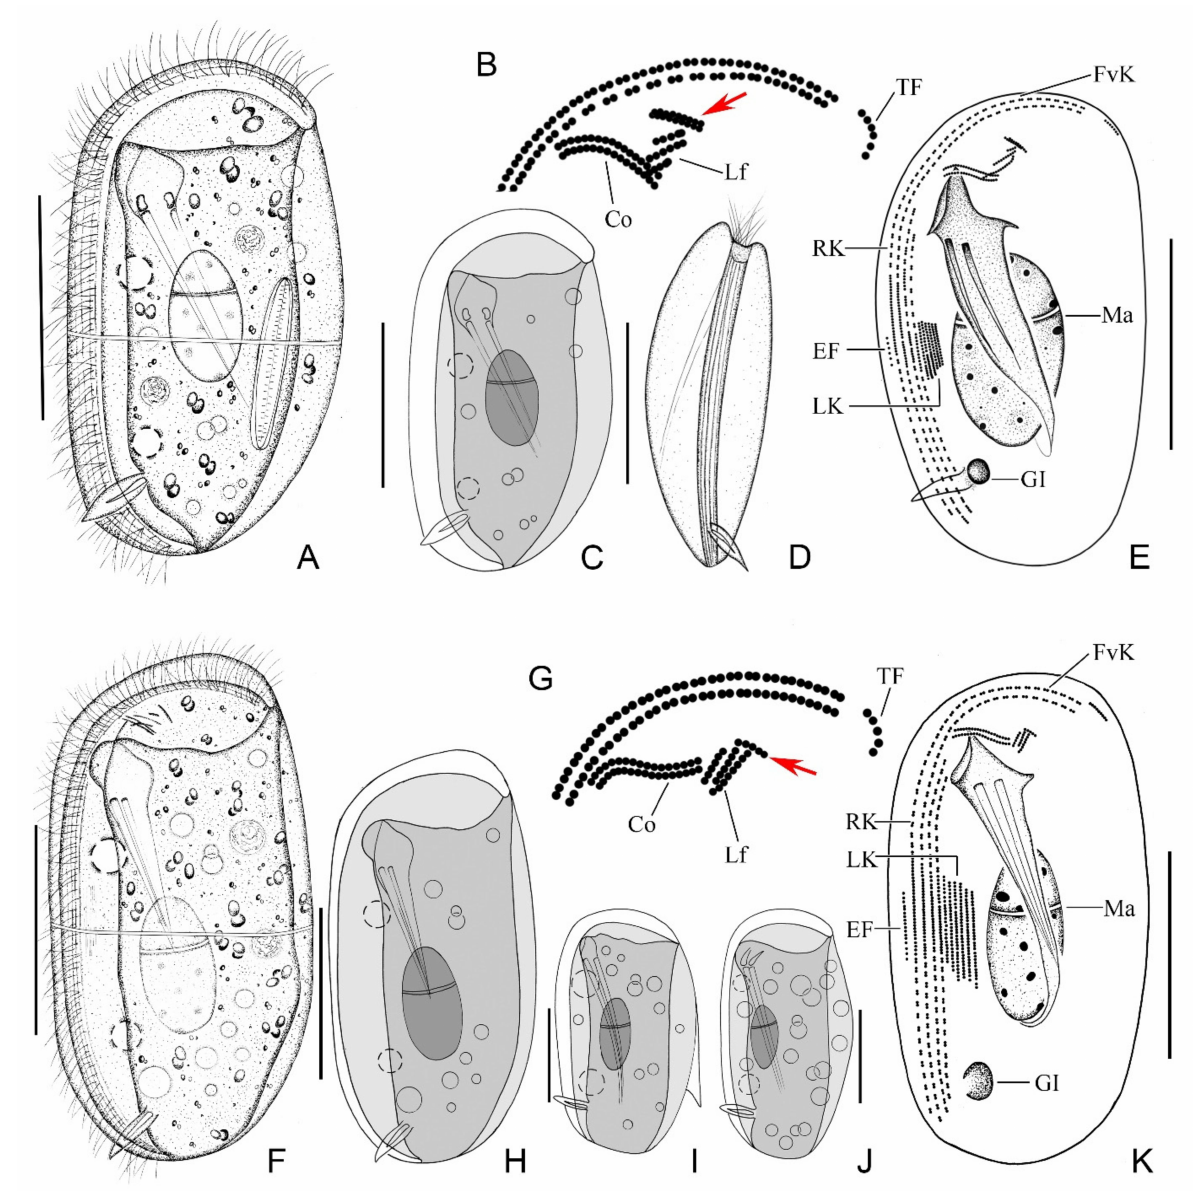
Figure 1. Dysteria paracrassipes n. sp. from life ( A , C , D ) and after protargol staining ( B , E ). Dysteria crassipes from life ( F , H – J ) and after protargol staining ( G , K ). ( A ) Left lateral view of a represen- tative individual. ( B ) Details of anterior region of cell showing the ciliary pattern; arrow shows double-rowed preoral kinety. ( C ) Showing the body shape. ( D ) Ventral view. ( E ) Left lateral view of the holotype specimen. ( F ) Left lateral view of a representative individual. ( G ) Details of anterior region of cell showing the ciliary pattern; arrow shows single-rowed preoral kinety. ( H ) Left lateral view of typical individual. ( I , J ) Representative individuals after Gong et al. [9]; note that the indi- vidual in ( I ) has a dorsal spine. ( K ) Left view showing the infraciliature. Co, circumoral kineties; EF, equatorial fragment; FvK, frontoventral kineties; GI, glandule; Lf, left front kineties; LK, left kineties. Ma, macronucleus; P, podite; Pr, preoral kinety; RK, right kineties; TF, terminal fragment. Scale bars = 25 µ